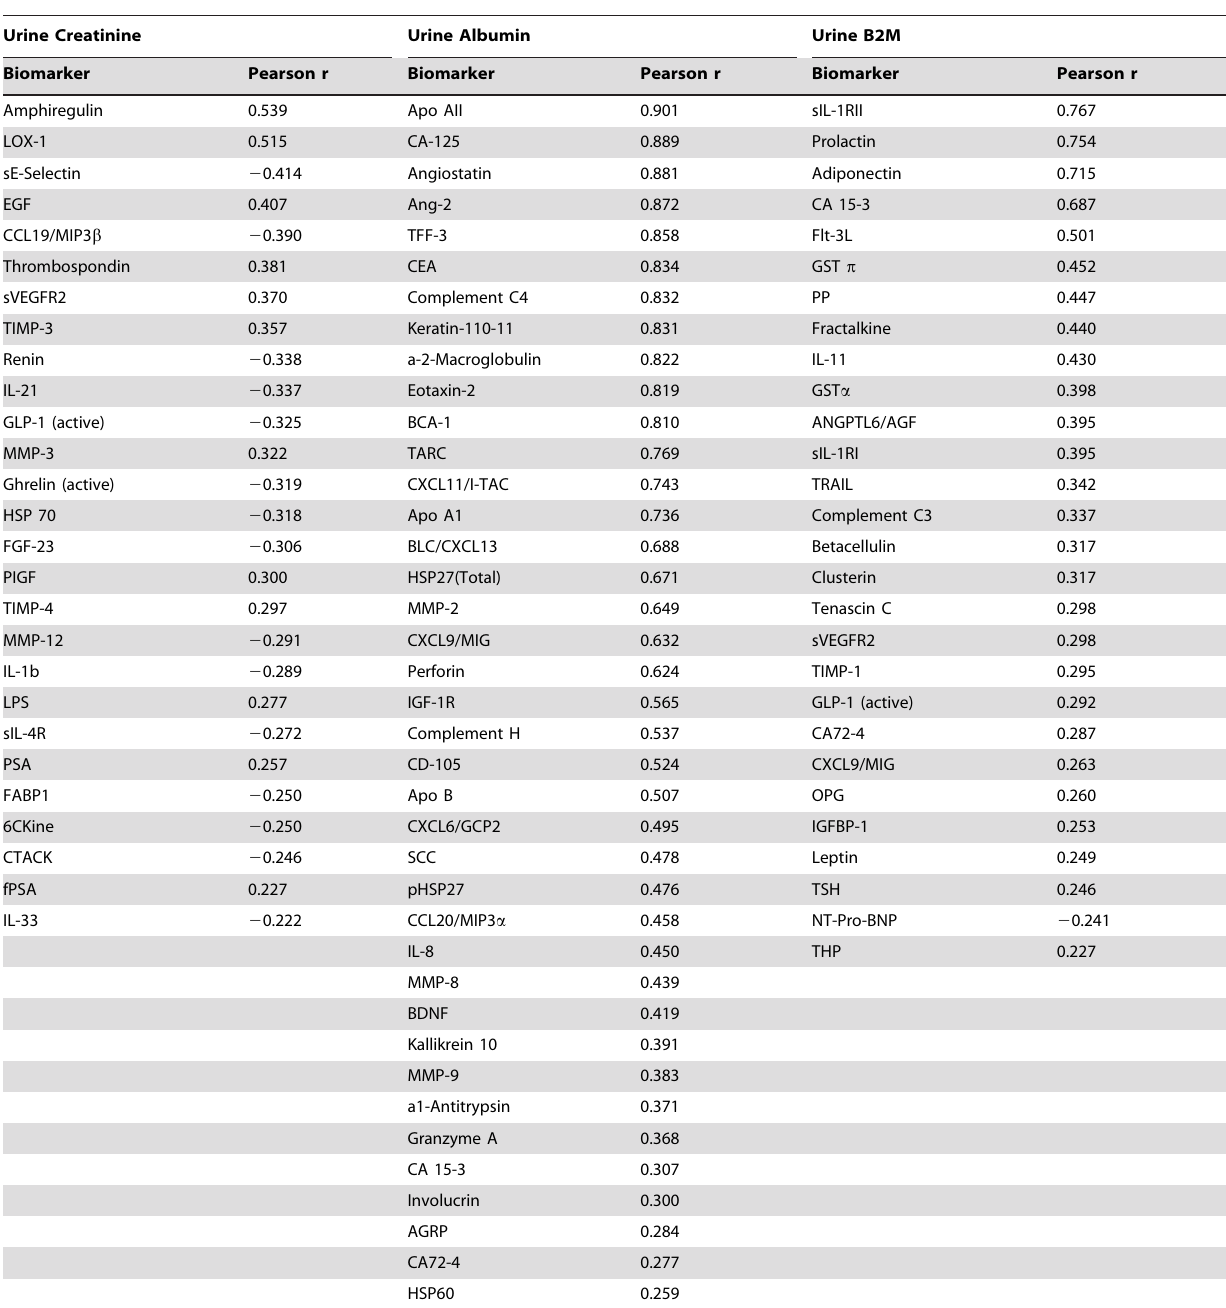
Table 3. Urine biomarkers correlating to specific urine